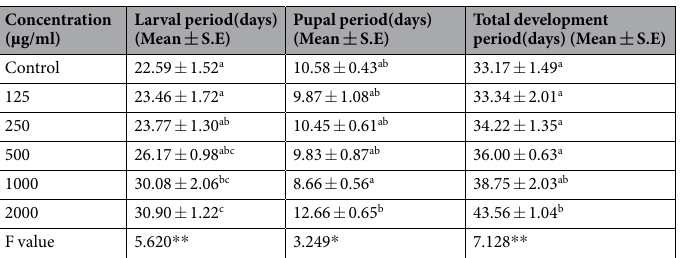
Table 3. Influence of ethyl acetate extract of S. commune on development of S. litura . The values are mean ± standard error. Significance ascribed as * p < 0.05 and ** p < 0.01 (One way ANOVA). Different letters a, b, c within the columns are significantly different (Tukey’s test, p ≤ 0.05) and signify the effect of concentration.